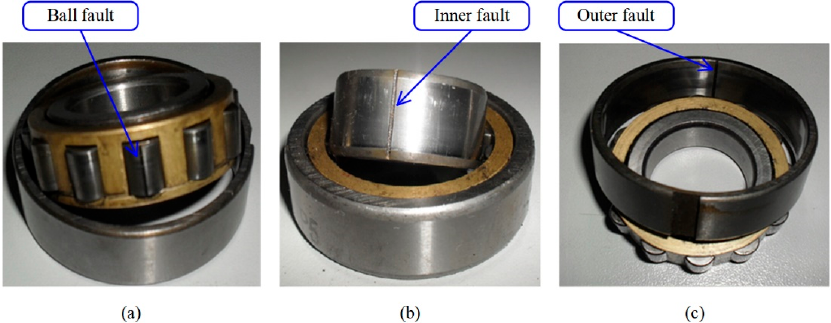
Table 10. The details of the 12 operating states.